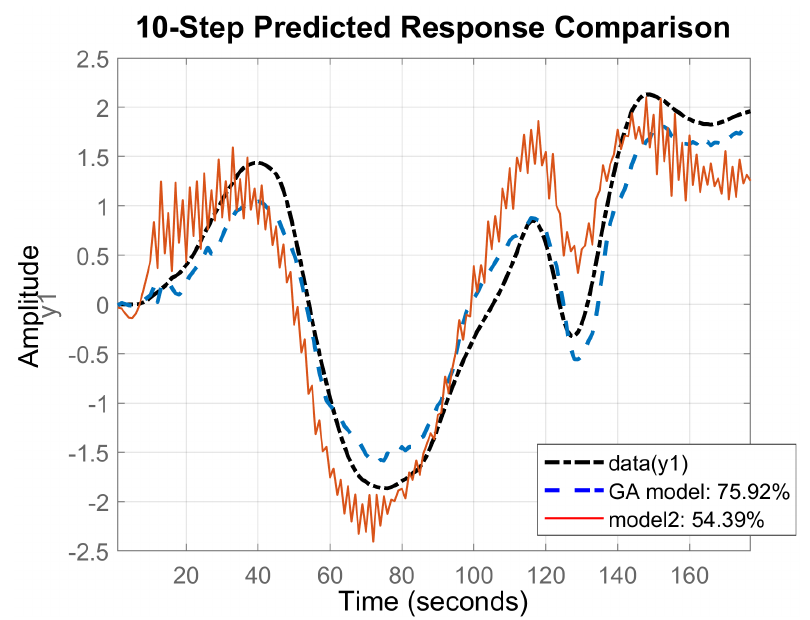
Figure 9. Regularized GA model and conventional model 10-step ahead prediction comparison based on real-time lake validation data.